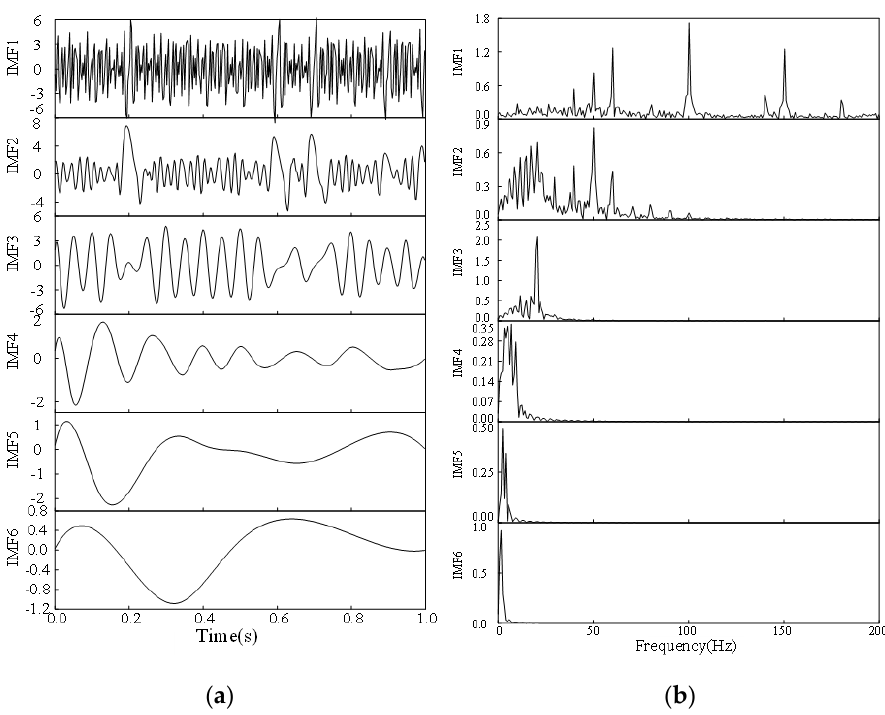
Figure 4. EMD decomposition result of the synthesized signal and its frequency spectrum. ( a ) EMD decomposition-component waveform; ( b ) EMD decomposition-component frequency spectrum.